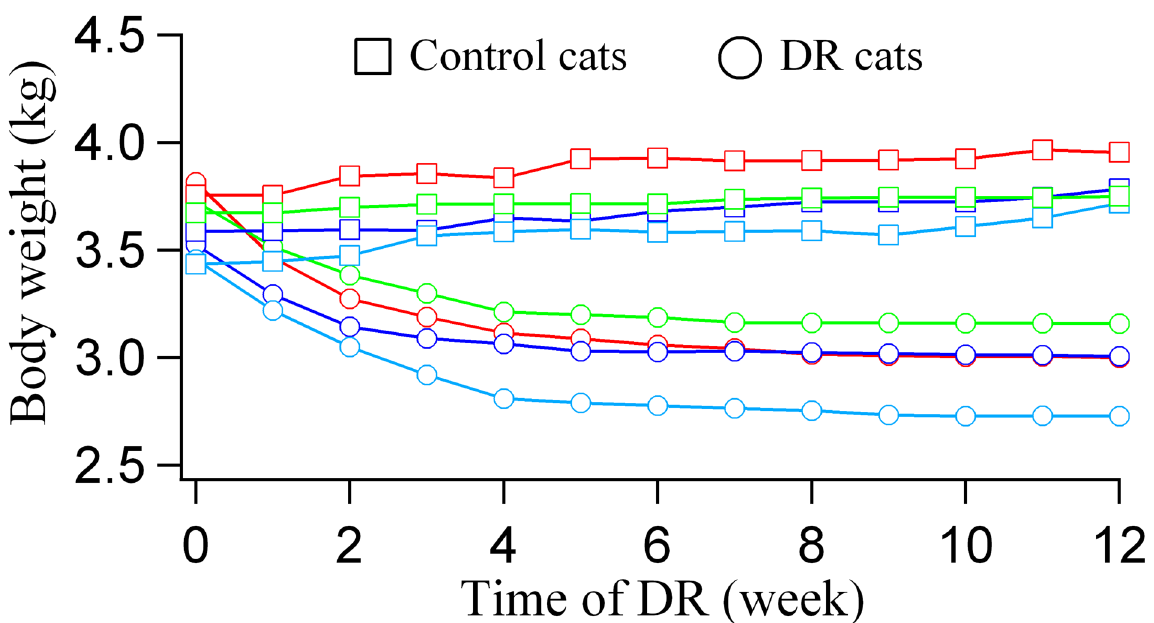
Fig 2. Body weight (BW) changes of each DR cat (open circle) and normal control cat (open square) during the period of DR. The BW of normal control cats (NC1: red; NC2: blue; NC3: cyan; NC4: green) showed an insignificant increase (p = 0.07), whereas the BW of DR cats (DR1: red; DR2: blue; DR3: cyan; DR4: green) were significantly decreased (p <